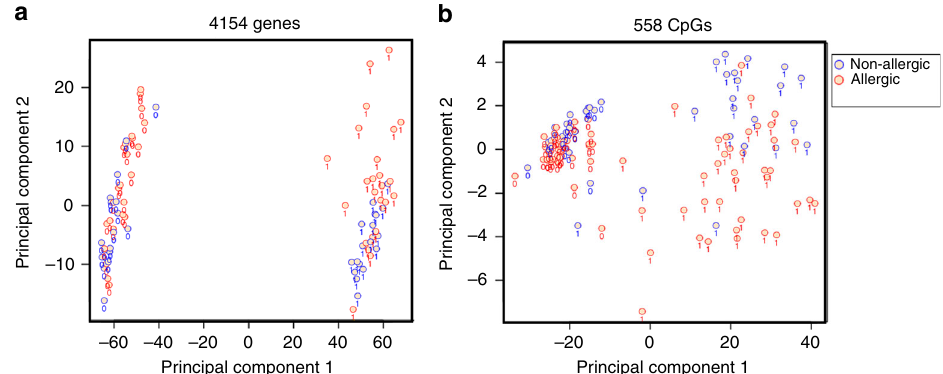
Fig. 3 Unsupervised clustering analysis of T cell activation genes reveals variation by food allergy status. Principal component clustering analysis of 12- month patient samples based on 4154 T cell activation response genes ( a ) and 558 CpGs ( b ). Samples are labeled according to activation status, 0 = quiescent, 1 = activated, and colored according to phenotype, blue = non-allergic, red =